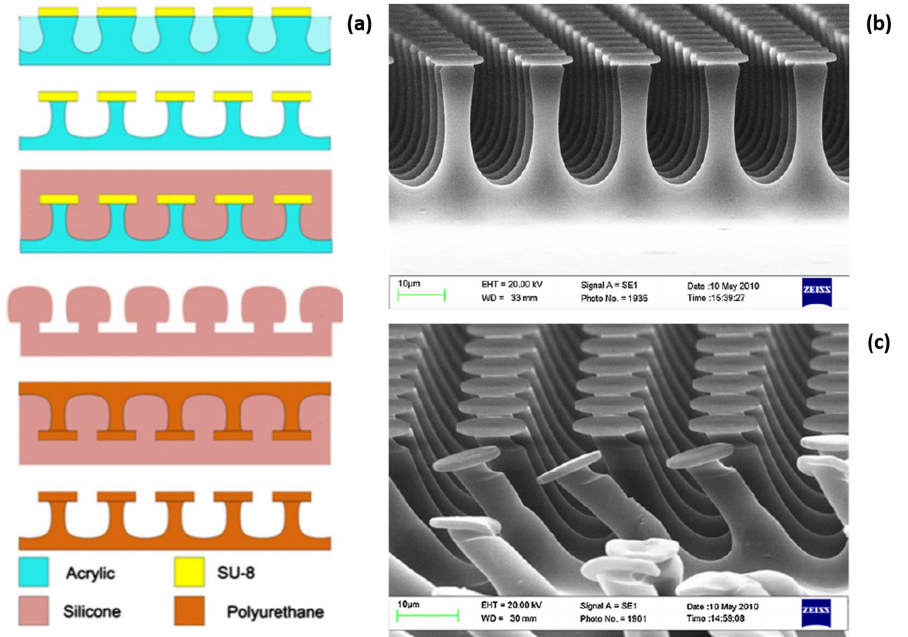
Figure 21. ( a ) A general fabrication procedure for making mushroom-like adhesive stamps. ( b ) SEM image of the resulting mushroom-like microstructures, and ( c ) SEM image of the stamp surface with tilted mushroom-like pillars formed by angled exposure. Adapted with permission from [256]. Copyright IEEE,